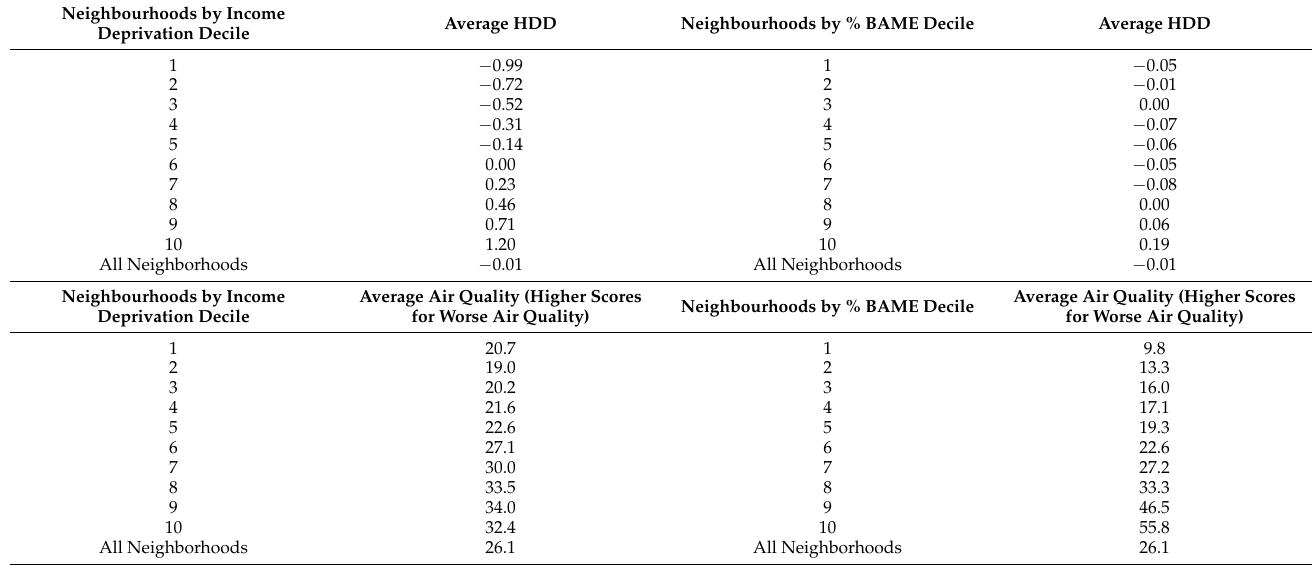
Table 6. Gradients in Health Deprivation (HDD) and Air Quality by Neighborhood Income Deprivation and % BAME. Neighbourhoods by Income Deprivation Decile Average